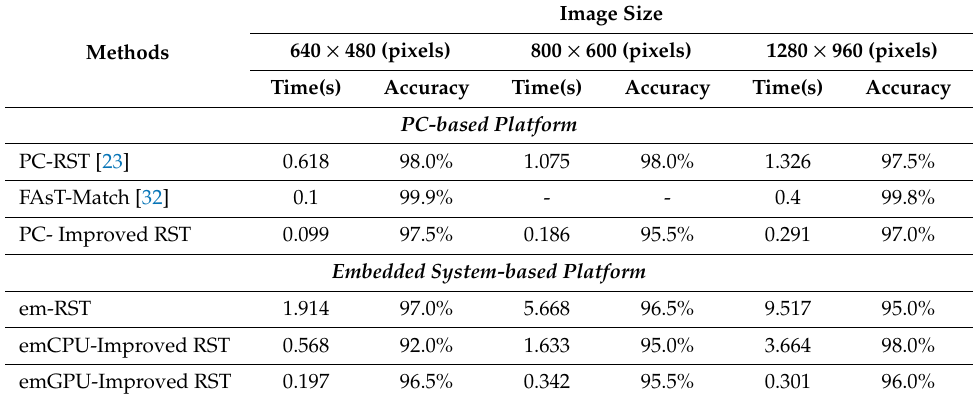
Table 2. Comparison of the average matching time and the accuracy of the RST template